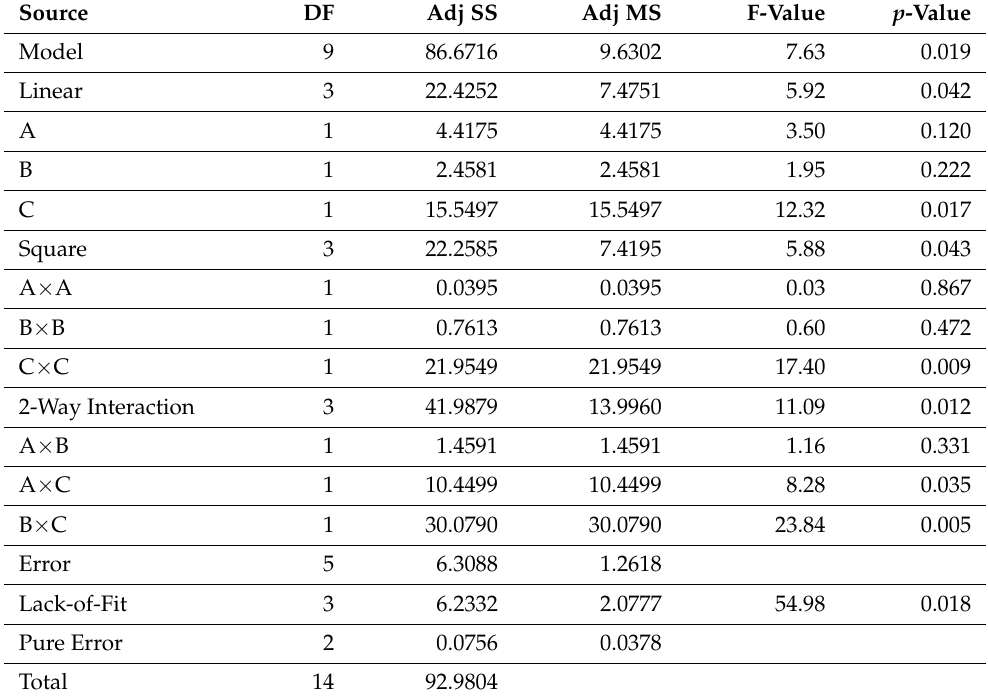
Table 5. ANOVA results for Young’s